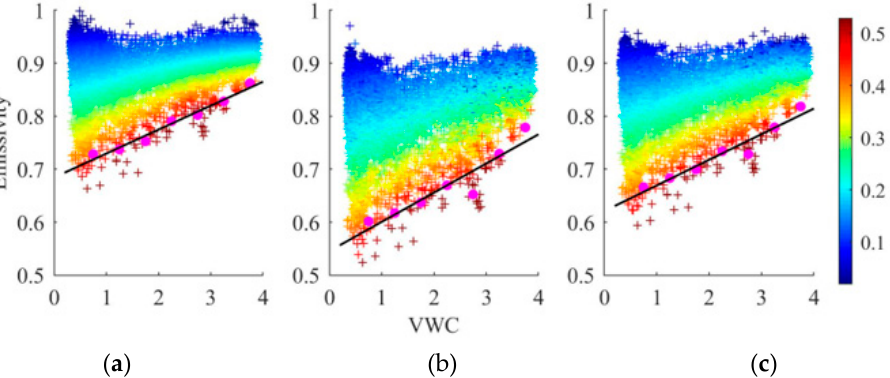
Figure 4. Minimum surface emissivity for vertical ( a ), horizontal ( b ) and combined vertical and horizontal ( c ) polarization at different VWC levels based on the descending SMAP dataset. The color of ‘ + ’ indicates the change in SSM. The pink circles represent e MIN calculated for each VWC interval. The black solid line is the fitted linear relationship between e MIN and VWC.